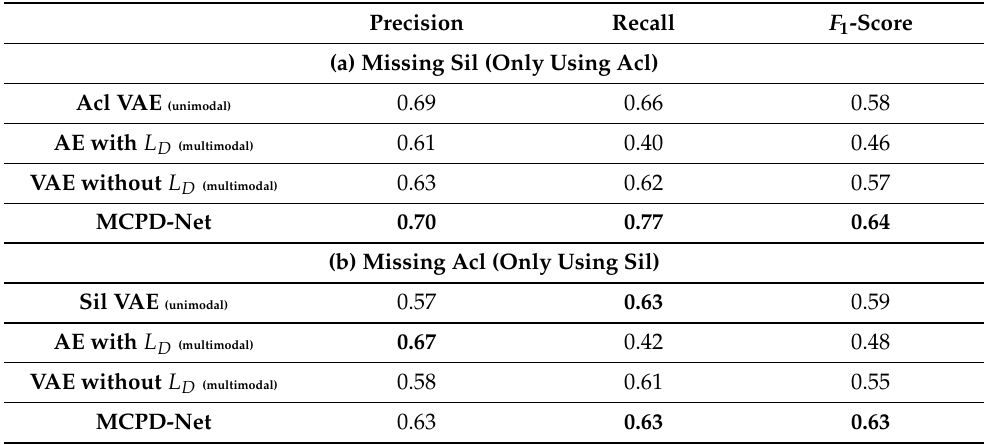
Table 3. Performance of MCPD-Net when 50% of the silhouette and accelerometer data are missing. This demonstrates an overall improvement by our proposed method.